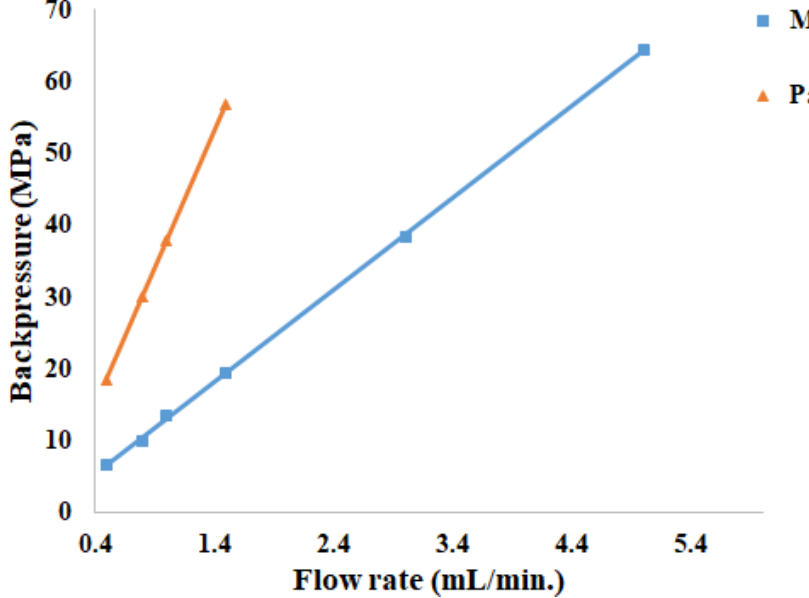
Figure 5. The influence of various flow rates on the back-pressure of monolithic and particle-packed columns . Table 2. The influence of flow rates on the backpressure of the instrument. Column Flow Rate (mL/min.) Pressure (MPa) Run Time (Min.) Chromolith ® C18 column 3 × 50 mm